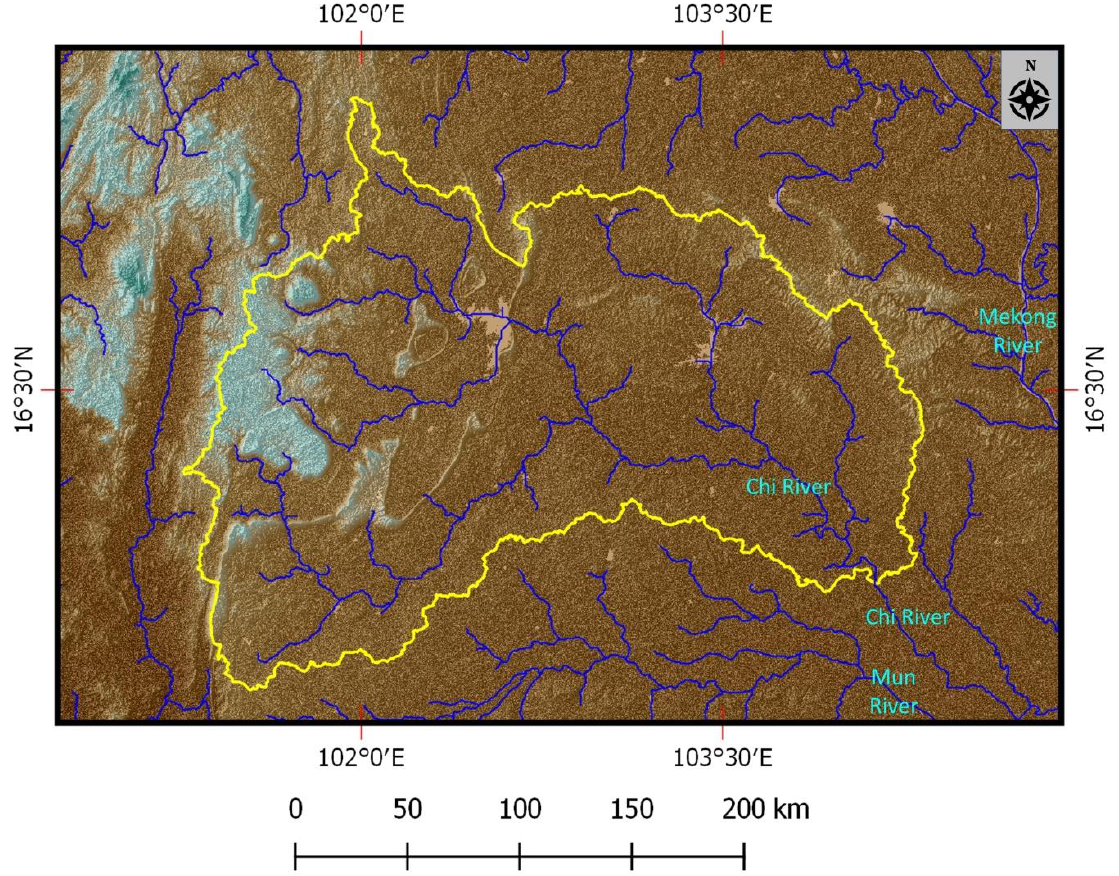
Figure 2. Terrain and principal waterways of the study area (sub-basin 7). The study area boundary is shown in yellow and the waterways are shown in blue. The underlying elevation map is from 30 m SRTM data in conjunction with the same legend shown in Figure